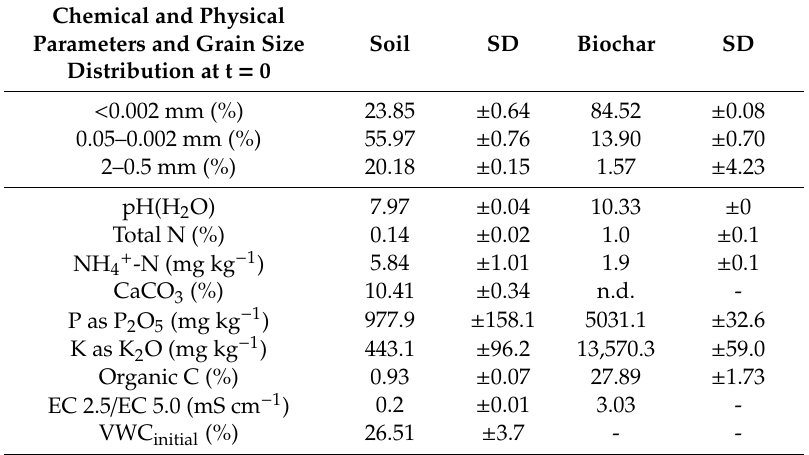
Table 1. Physical and chemical characteristics of the soil and biochar used in the experiment. n = 3; mean ± SD. Volumetric water contents (VWC) represents volumetric water